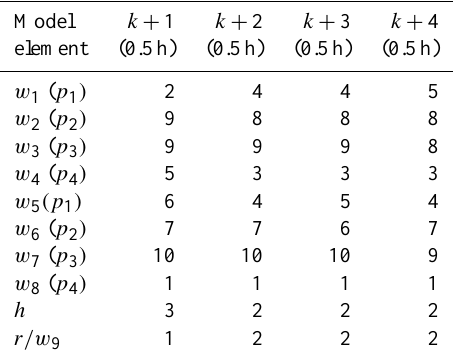
Table 3. Optimal architecture selected using cross-validation for various forecast lead